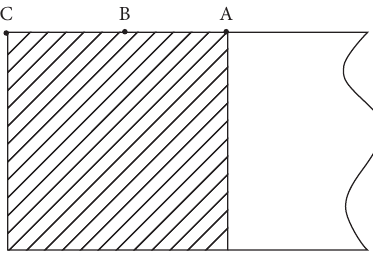
Figure 14: Selection of particular nodes.